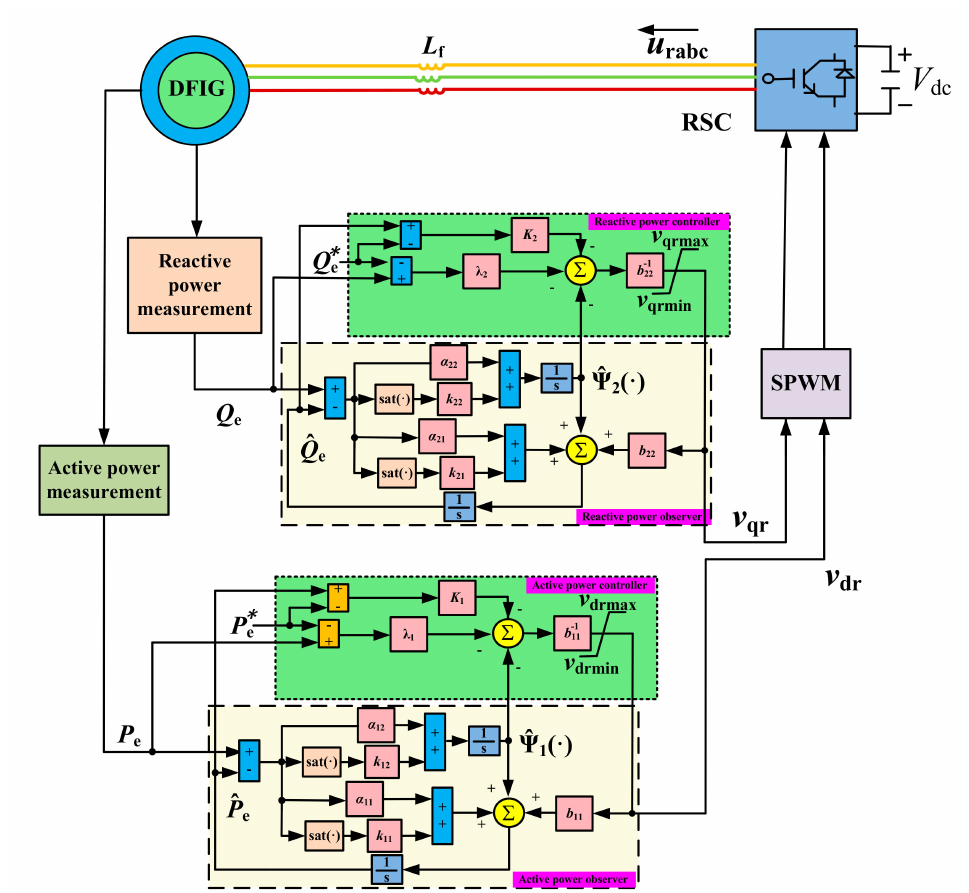
Figure 2. The overall RPC structure of